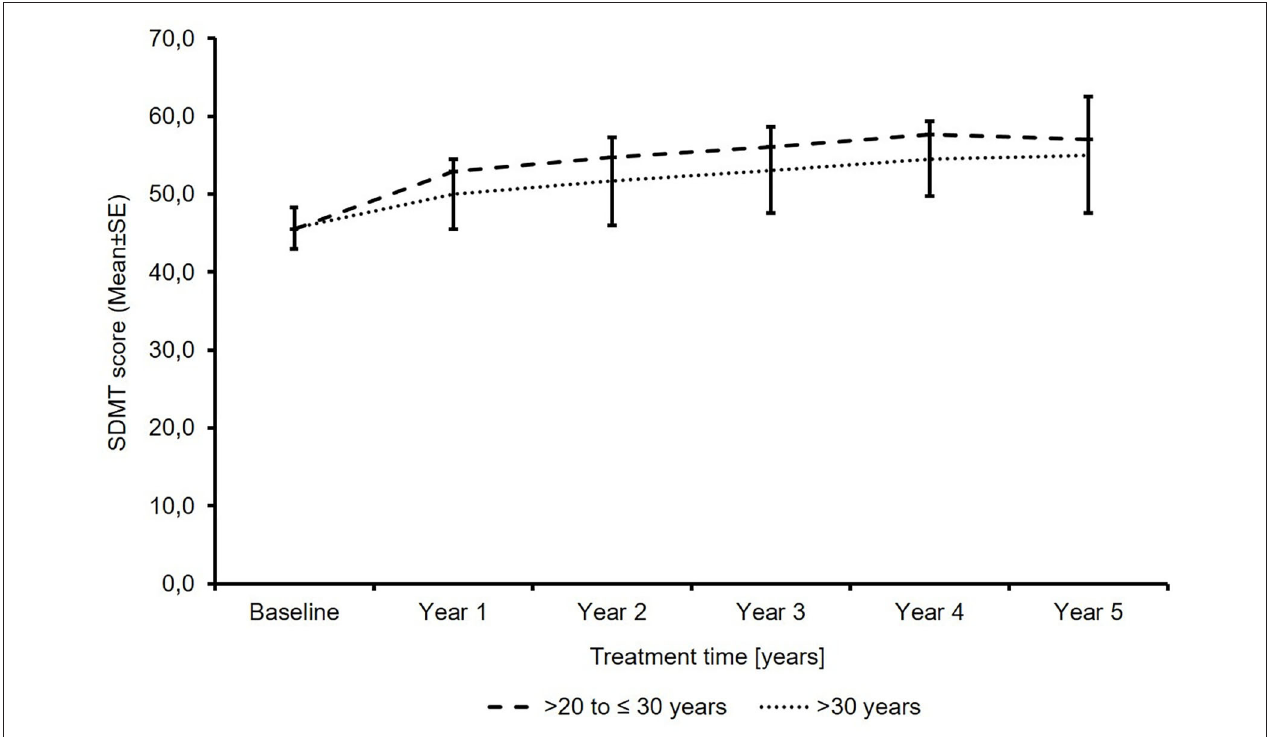
FIGURE 4 | Total symbol digit modalities test score ( N ′ > 20 to ≤ 30 years: 26/18/14/12/11/8; N ′ > 30 years: 189/173/151/120/89/67; baseline/year 1/year 2/year 3/year 4/year 5).